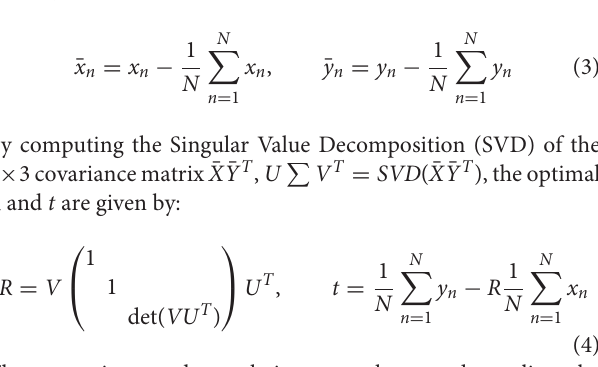
FIGURE 6 | Generated 3D Point cloud of the Brighton Dam: (A) Downstream face; (B) Upstream